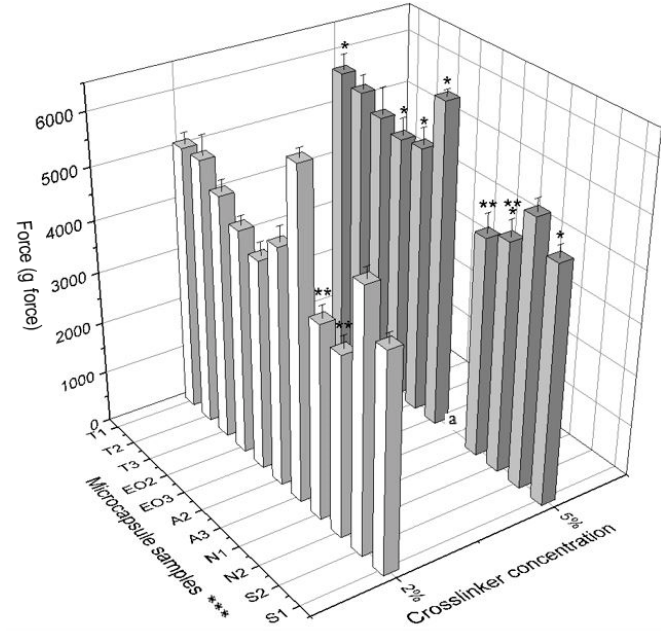
Figure 10. The firmness of NEO-loaded calcium alginate microcapsules. * p < 0.05 vs. force for crushing NEO-loaded microcapsules prepared by using 2% crosslinker solution. ** p < 0.05 vs. force for crushing NEO-loaded microcapsules prepared by using magnesium aluminometasilicate as excipient. A force for crushing A3 (5% calcium chloride solution) was not measured, it was higher =